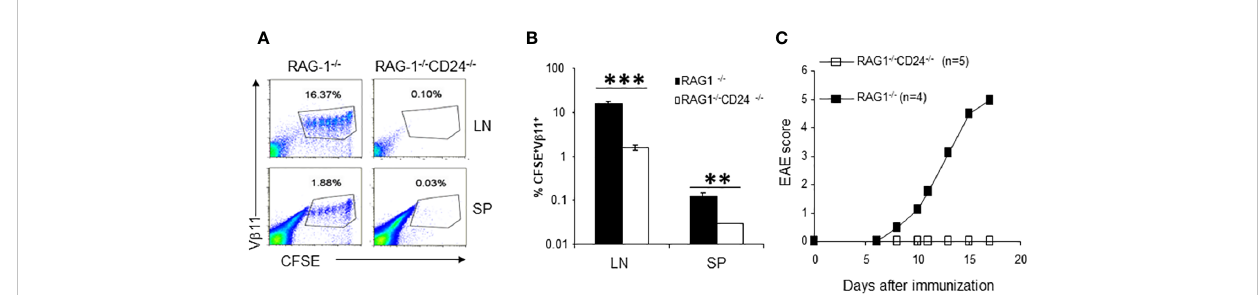
FIGURE 5 2D2 T cell proliferation and pathogenicity in RAG-1 -/- CD24 -/- mice. (A, B) . 2D2 T cells accumulated in the draining lymph nodes [upper panel of (A) ] and spleens [lower panel of (A) ] of RAG-1 -/- mice but not in RAG-1 -/- CD24 -/- mice. 5 x 10 6 CFSE-labeled 2D2 T cells were injected into each recipient mouse i.v. followed by immunization with MOG 35-55/CFA. Flow cytometry analysis of lymph node cells were performed at 65 h. Percent of CFSE + V b 11 + cells in each group were plotted in (B) . **P<0.01, ***P<0.001 by student's t test. Five mice per group were used in this experiment and data shown represents Mean ± SD. Student ’ s t test was used for the statistical analysis. (C) . RAG-1 -/- CD24 -/- mice receiving 2D2 T cells failed to develop EAE. 2 x 10 6 of CD4 T cells from 2D2 TCR transgenic mice were injected into each RAG-1 -/- and RAG-1 -/- CD24 -/- mouse i.v. The recipients were then immunized for EAE using MOG35-55/CFA/PT. Data shown represents two experiments with similar